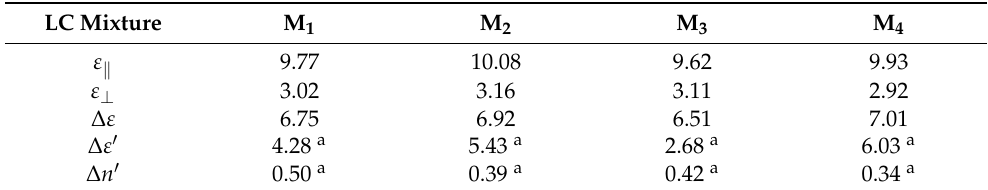
Table 2. Dielectric anisotropy and the corresponding parallel and perpendicular electric primitivities of LC mixtures M 1 – M 4 at 25 ◦ C.